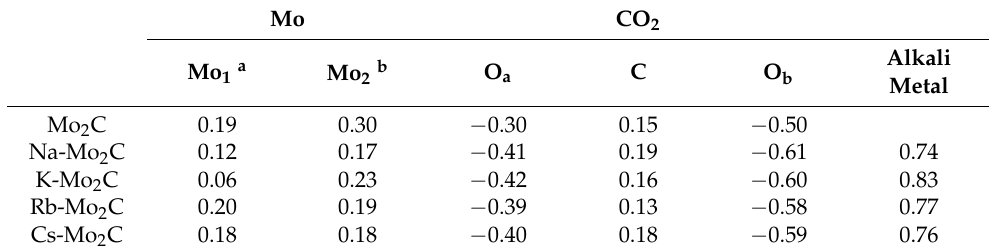
Table 3. Mulliken charges ( e ) of key atoms in the calculated transition states.